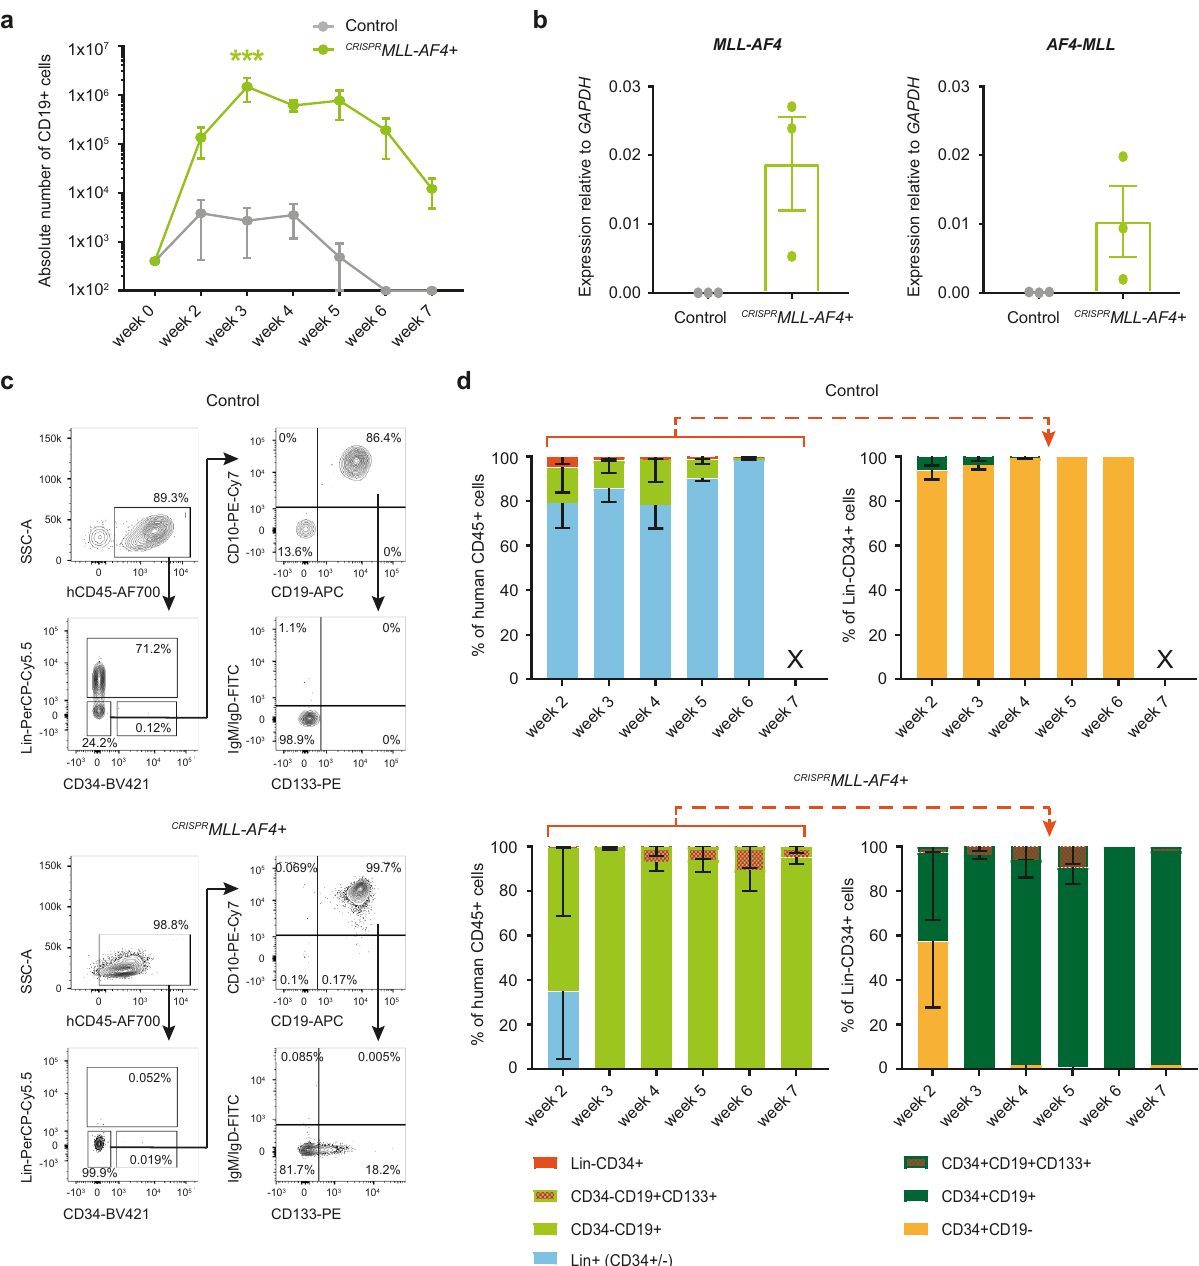
Fig. 2 A CRISPR-Cas9-induced t(4;11)/ MLL-AF4 translocation in human FL HSPCs causes a dramatic increase in B-lineage cell proliferation in vitro. a Cumulative absolute number of human CD45 + CD19 + cells per well over time during CRISPR MLL-AF4 + and control MS-5 coculture ( n = 3; donors 1 – 3). *** p < 0.005 (two-way ANOVA with Sidak correction for multiple comparisons). Data are shown as mean ± SEM. Source data are provided as a Source Data fi le. b RT-qPCR of human CD45 + cells showing expression of MLL-AF4 and AF4-MLL ( n = 3; donors 1 – 3) relative to GAPDH at week 4 of MS-5 coculture. Data are shown as mean ± SEM. Source data are provided as a Source Data fi le. c . Representative fl ow cytometry plots of viable, single cells from control and CRISPR MLL-AF4 + cultures on week 4 of coculture. Custom lineage cocktail (Lin) = CD2/CD3/CD14/CD16/CD56/CD235a (Supplementary Table 4). d Quanti fi cation of human cell immunophenotypes as a percentage of human CD45 + (hCD45 + ) cells (left), and progenitor immunophenotypes as a percentage of hCD45 + Lin − CD34 + cells (right), in control ( n = 3; donors 1 – 3) and CRISPR MLL-AF4 + ( n = 3; donors 1 – 3) cultures over time. X = data not shown because absolute number of hCD45 + cells is <50. Data are shown as mean ± SEM. Source data are provided as a Source Data fi le. ( p < 0.005), suggesting that the translocation had successfully con fi rmed the expression of both MLL-AF4 and AF4-MLL in CRISPR MLL-AF4 + cultures (Fig. 2b). Virtually all human cells transformed the cells (Fig. 2a). Fluorescence in situ hybridization (FISH) using MLL and AF4 probes con fi rmed the presence of a generated from CRISPR MLL-AF4 + cultures (Supplementary heterozygous MLL-AF4 /t(4;11) translocation in >80% (range Fig. 3c) were CD19 + cells, compared to <20% in control cultures 80 – 98%) of cells analyzed ( n = 4; donors 4 and 5); Supplementary (Fig. 2c, d, left). Although the proportion of CD34 + cells in Fig. 3b). Quantitative reverse transcription-PCR (RT-qPCR) CRISPR MLL-AF4 + cultures was reduced, the absolute number of NATURE COMMUNICATIONS| (2021) 12:6905